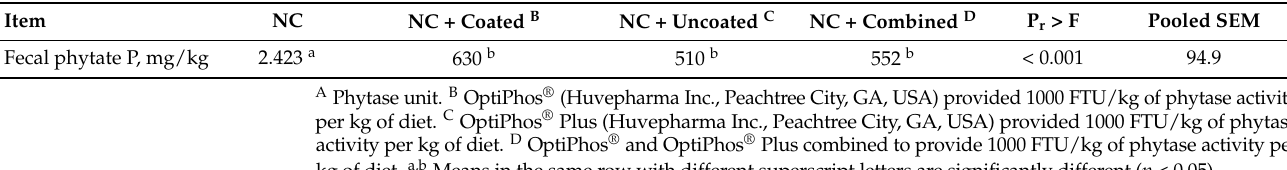
Table 5. Influence of negative control (NC), coated phytase supplementation (NC + 1000 FTU A coated phytase supplementation (NC + 500 FTU coated + 500 FTU uncoated) on phytate